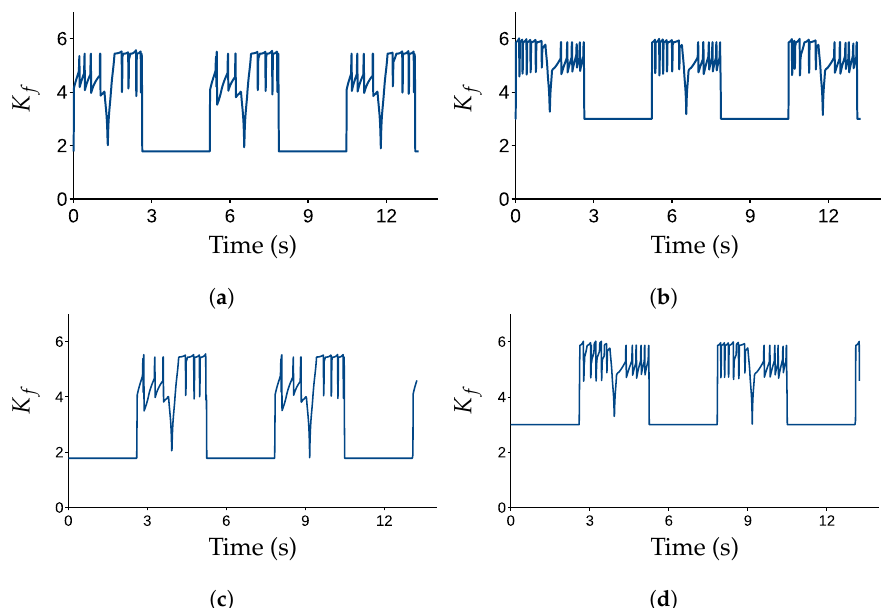
Figure 7. K f changes over time for left hip, left knee, right hip, and right knee: ( a ) left hip, ( b ) left knee, ( c ) right hip, ( d ) right knee.